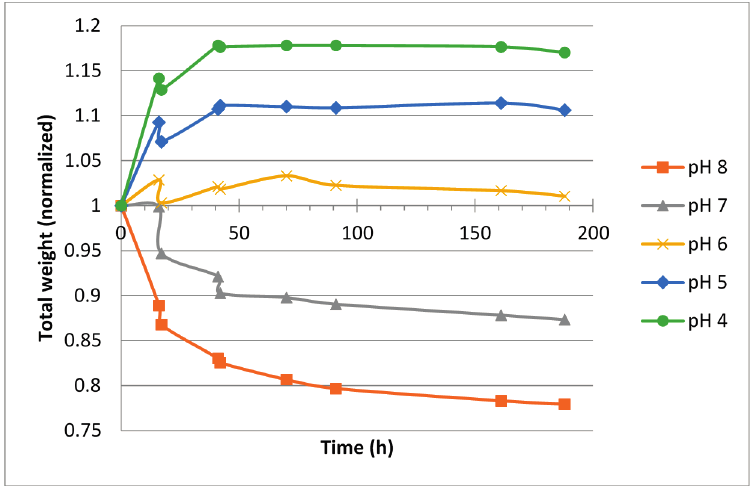
Figure 3. Weight change over time for blocks made from isotonic